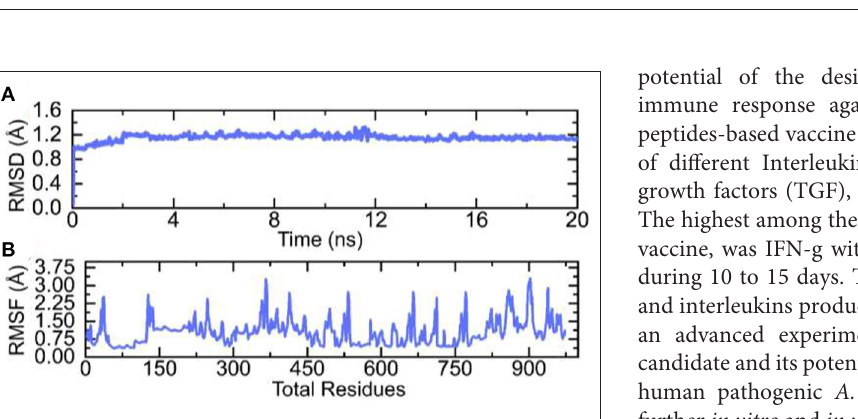
FIGURE 6 | The immune simulation graphs showing immune response produced against the antigenic peptides-based vaccine design. (A) The graph showing antigen count/ml/day plotted against Ab titers. (B) The production of cytokines and interleukins against the whole proteome-wide peptides-based vaccine design.